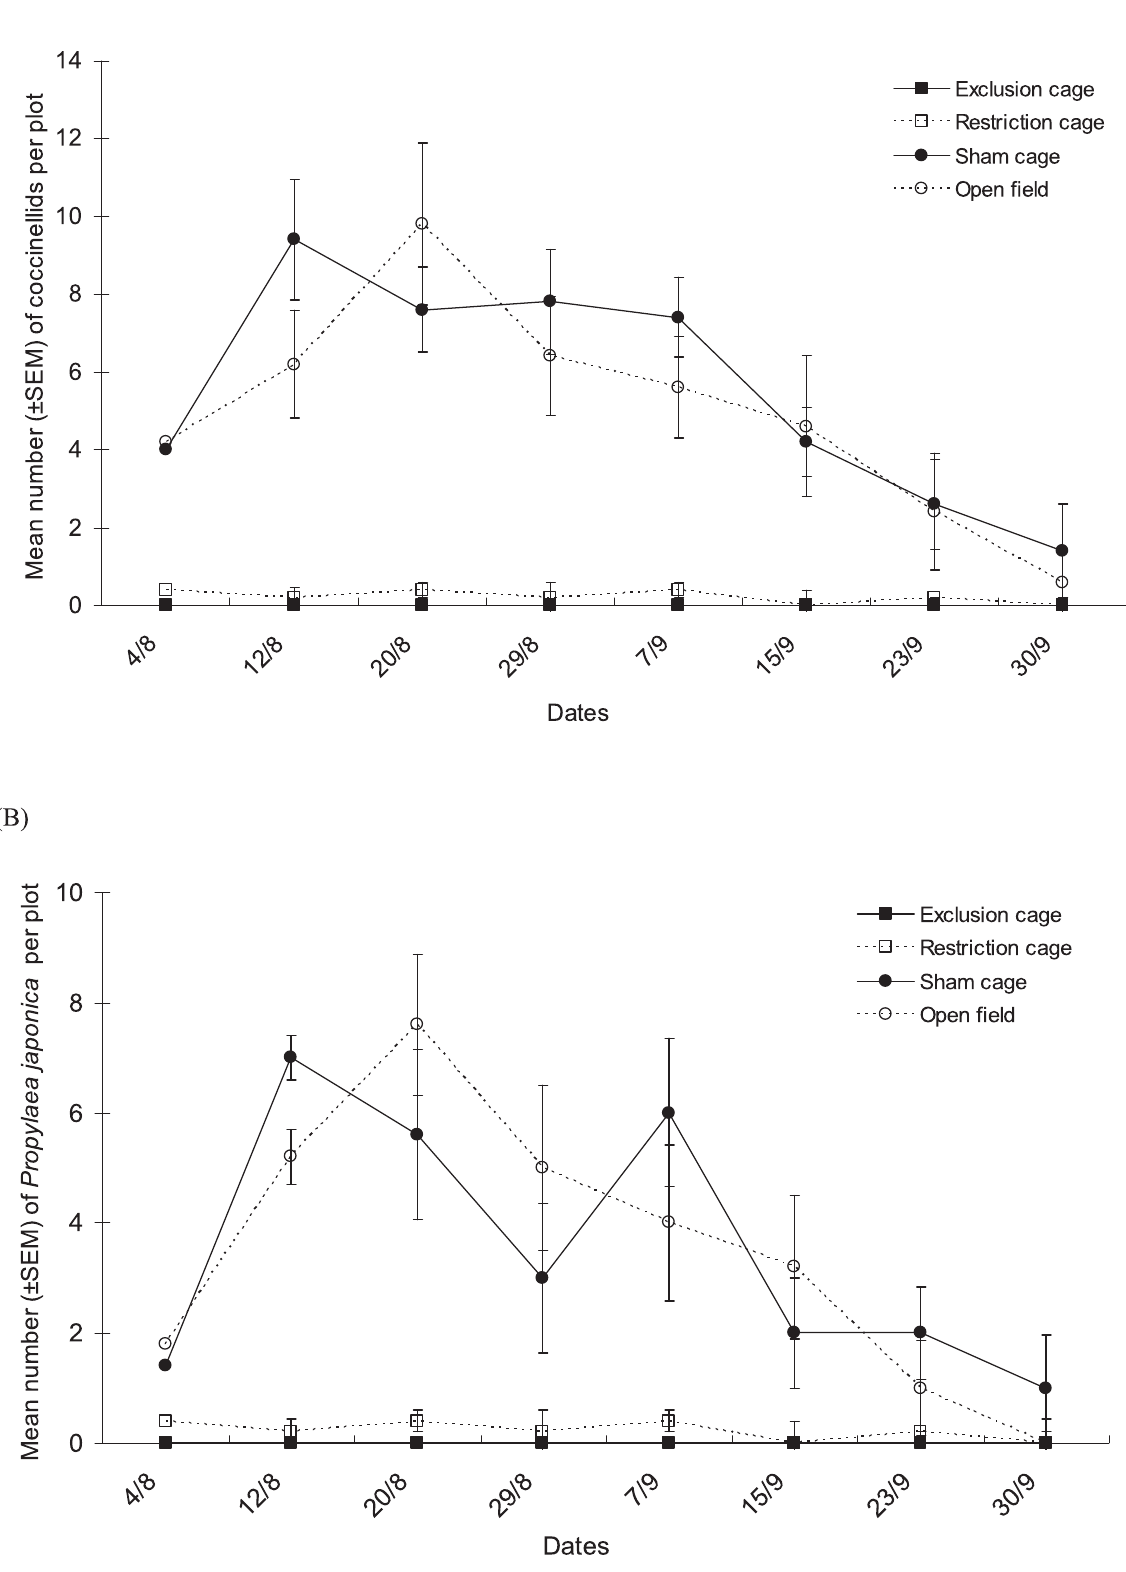
Figure 3. Population dynamics of coccinellid predators. Mean numbers ( 6 SEM) of ( A ) all Coccinellids and ( B ) P. japonica per plot in the various natural enemy exclusion treatments from early August to end of September in Bt cotton in Ezhou (China). doi:10.1371/journal.pone.0102980.g003 PLOS ONE | www.plosone.org